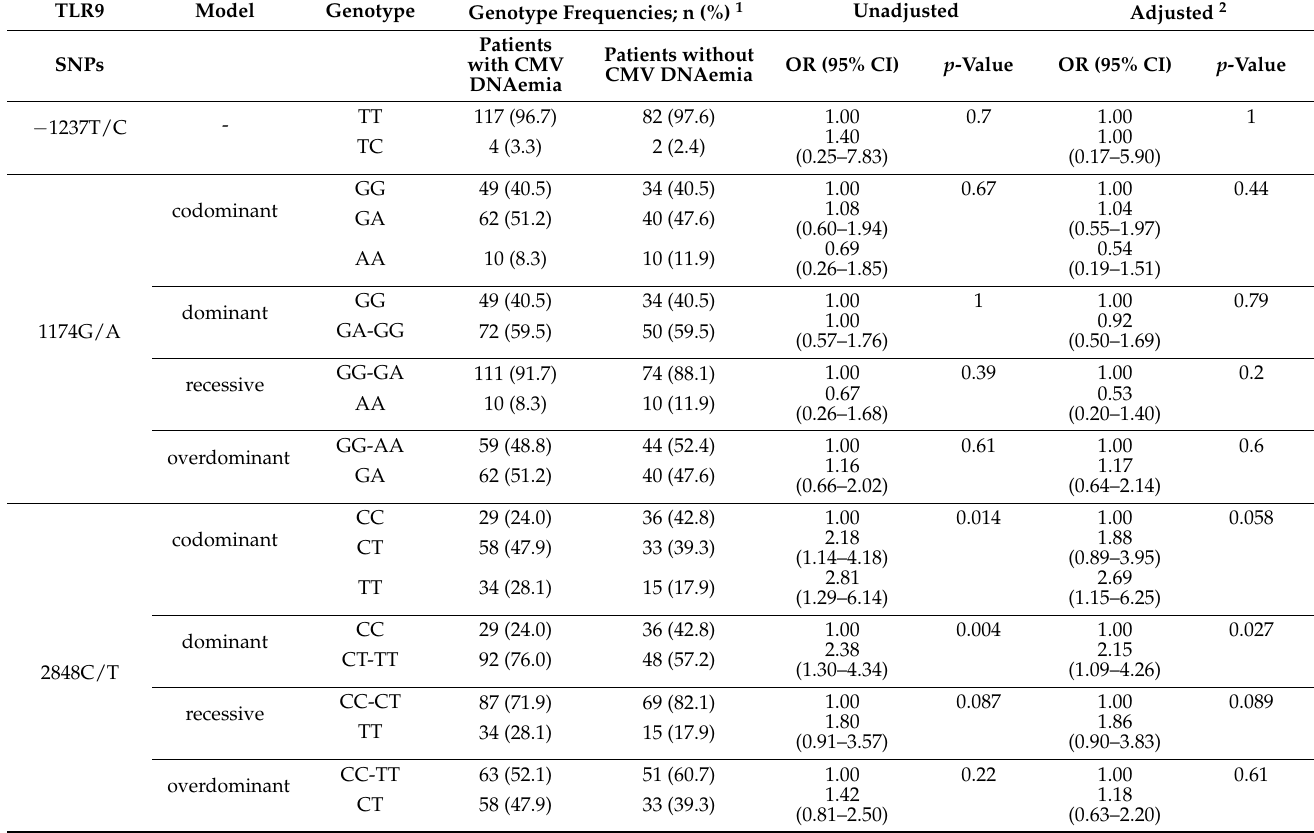
Table 3. Associations between target TLR9 polymorphisms and HIV/CMV